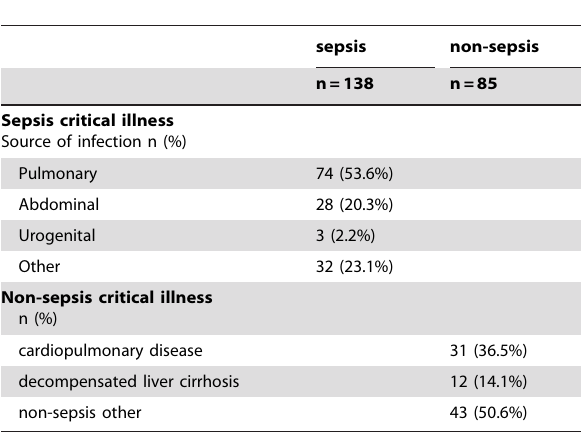
Table 2. Disease etiology of the study